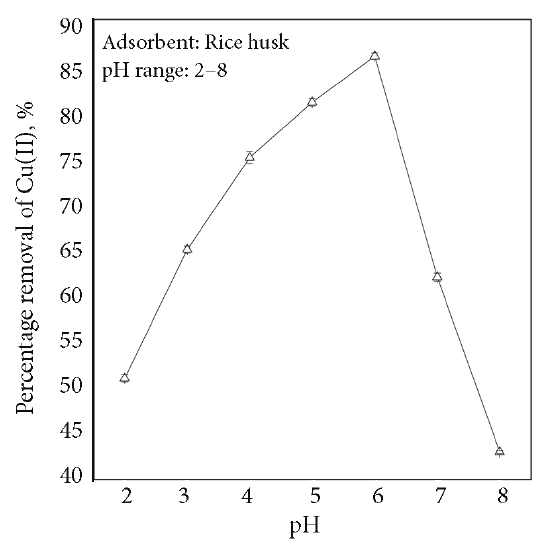
Figure 4. Effect of the bed depth